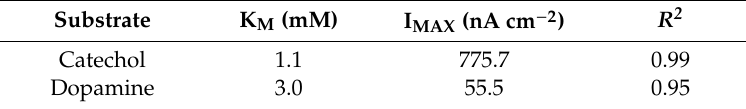
Figure 5. Plot of the catalytic current towards increasing concentrations of ( ■ ) catechol and ( ● ) dopamine for electrodes (measurements performed by chronoamperometry at E = − 0.2 V vs. SCE, 0.1 M PBS, pH 6, 25 °C) . Table 2. Electrochemical characteristics obtained after modelization of the curve according Michaelis–Menten kinetics; equation: I = (I MAX × [substrate]) / (K M + [substrate]).